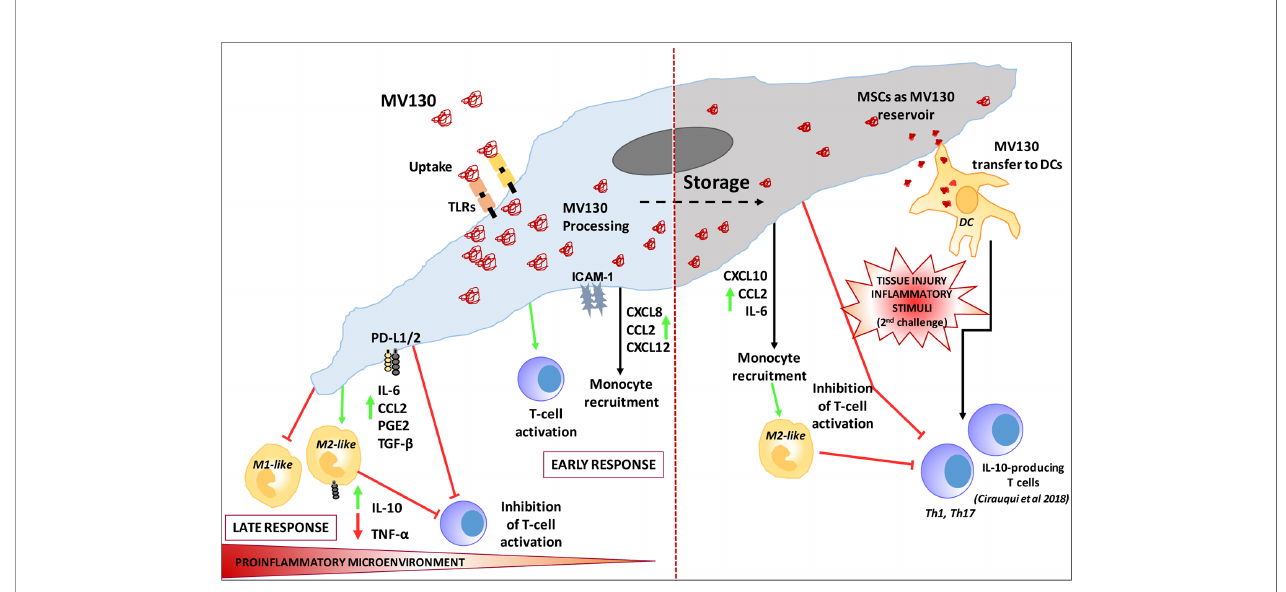
FIGURE 6 | Proposed Model of MSC involvement in oral mucosal bacterial immunotherapy with